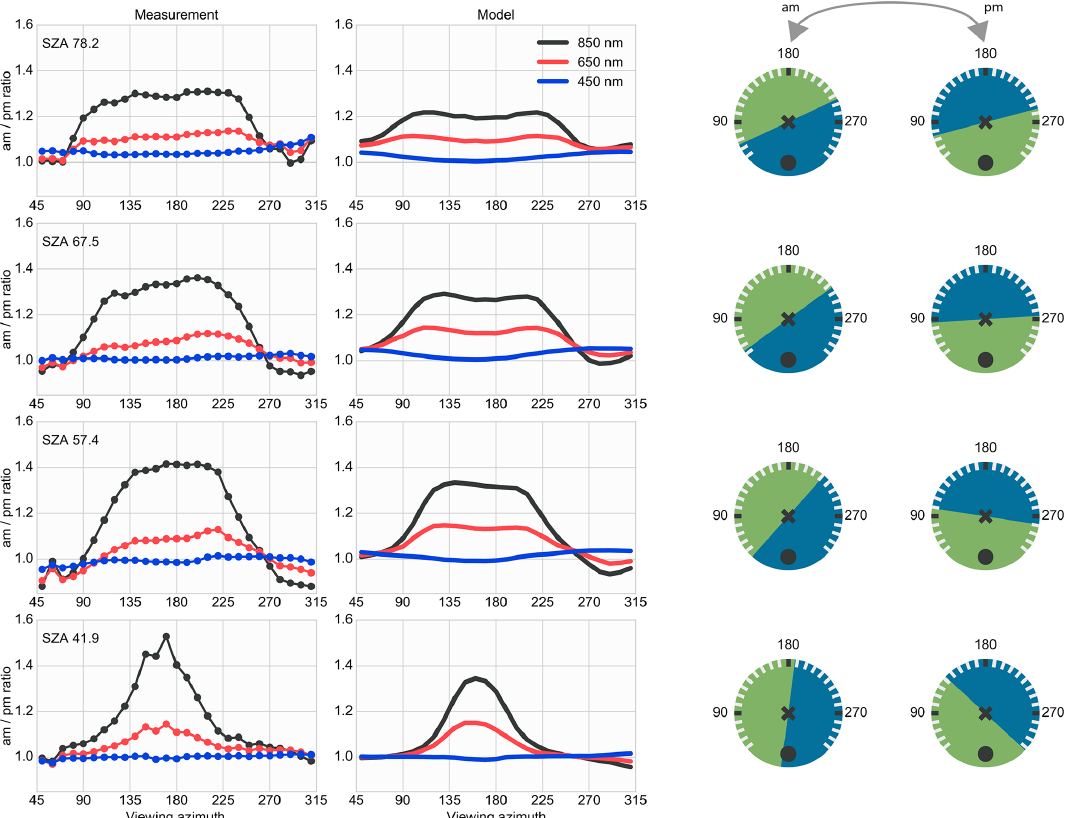
Figure 4. Asymmetry between morning and afternoon: measured and modelled am–pm ratios of the radiances at 70 ◦ zenith angle at three wavelengths and four SZAs at the coastal site. The viewing azimuth angles and the coastline are again illustrated on the right. The ratios are higher than 1 for viewing azimuths, where the underlying albedo differs from am to